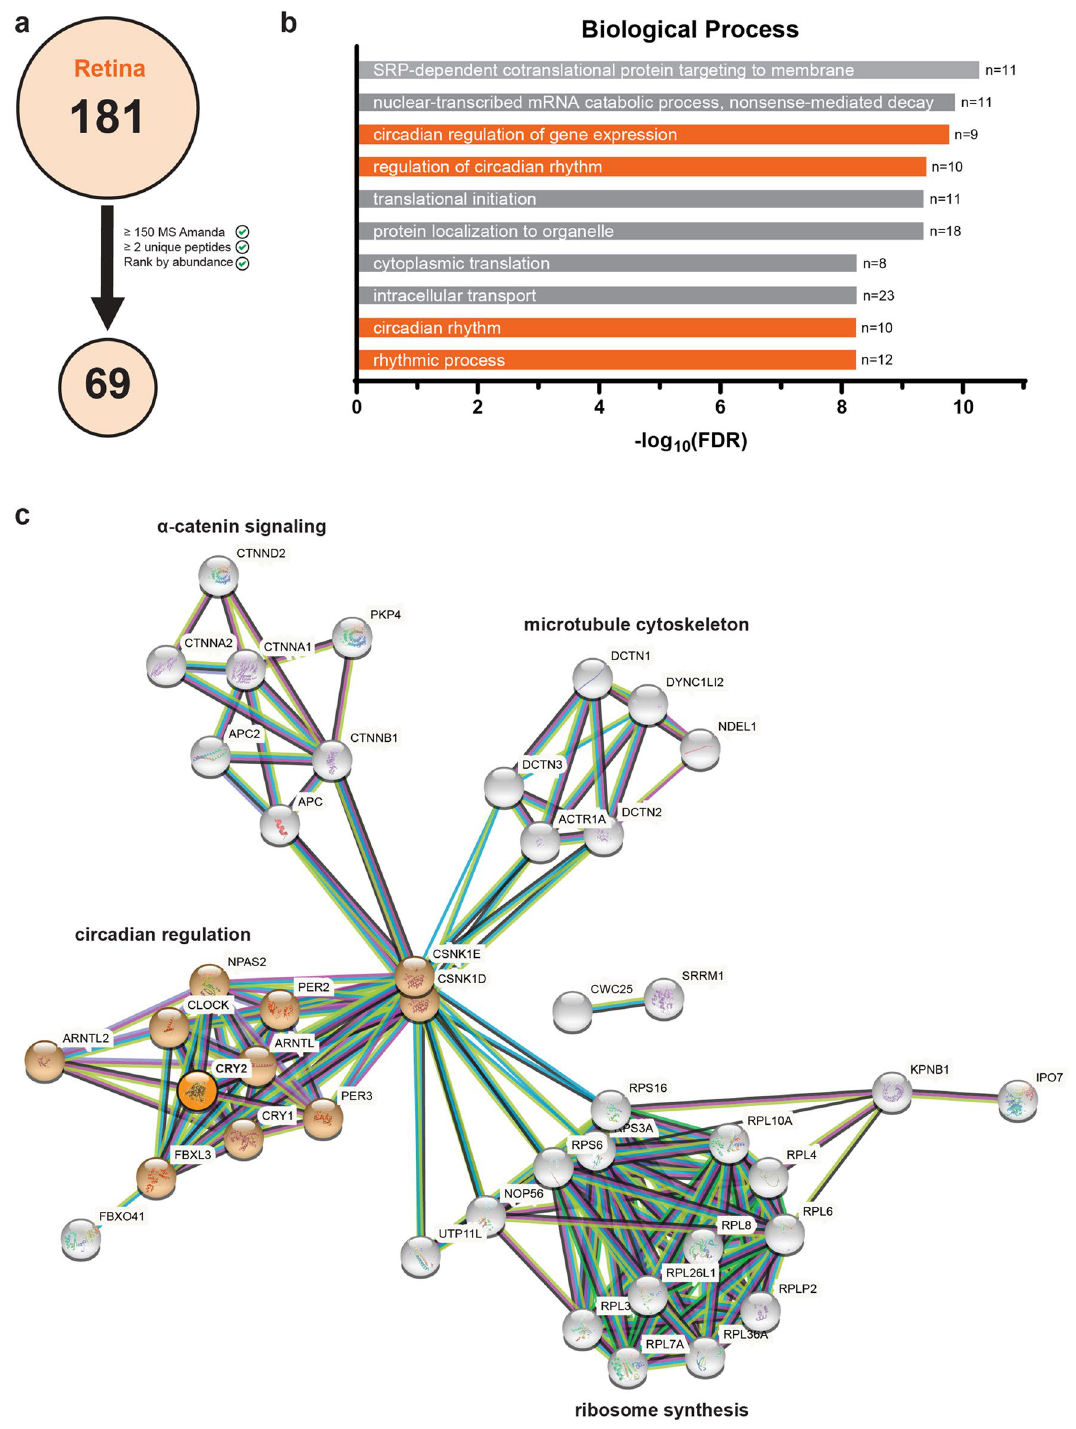
Figure 5. Putative clCRY2a/b interaction partners at midday. ( a ) Schematic depicting putative clCRY2a/b interactors coimmunoprecipitated with the 2A3 clCRY2a/b antibody from pigeon retina harvested at midday (12:00 CET). In total, 181 putative clCRY2a/b interactors that were not present in samples incubated with a control GFP antibody were pulled down from retinal lysates. Hits were ranked by average abundance and filtered for having an Amanda MS score of > 150 and 2 or more unique peptides. After this filtering strategy was preformed, 69 hits were identified in the retina. ( b ) Gene ontology (GO) analysis of clCRY2a/b and 68 putative clCRY2a/b interactors revealed an enrichment of proteins associated with multiple circadian rhythm GO-terms (orange). The top ten GO-terms based on FDR significance are shown. ( c ) STRING analysis (Version 11.0b, https:// string- db. org/, STRING Consortium 2020 59 ) shows clCRY2a/b interactors cluster in four distinct groups. Hits containing the circadian GO-terms highlighted in ( b ) are colored